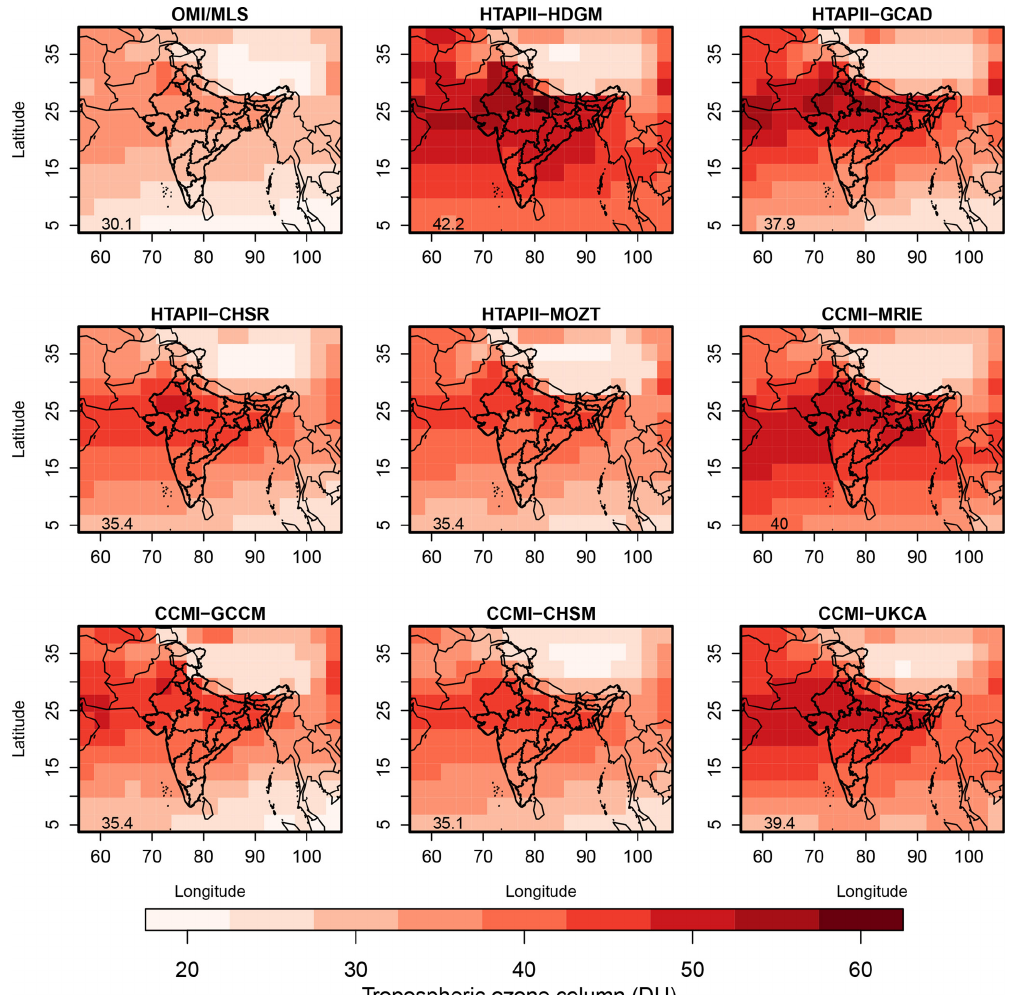
Figure 10. OMI/MLS-determined and model-simulated annual average tropospheric ozone column (AATOC) in Dobson units (DU) over the Indian subcontinent. Values in the bottom left corner indicate the mean AATOC in the